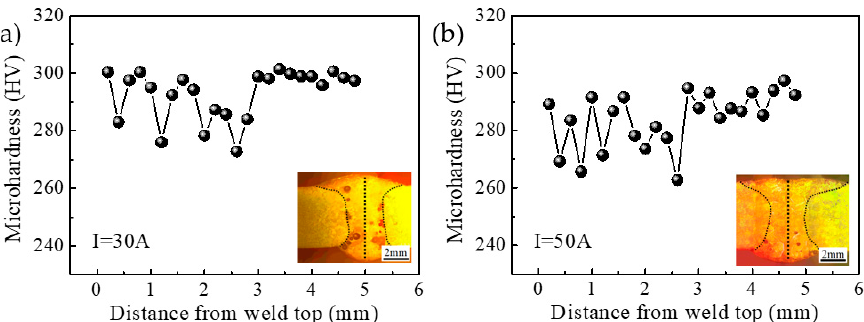
Figure 14. Microhardness distribution of vertical weld with different currents: ( a ) I = 30 A; ( b ) I = 50 A.